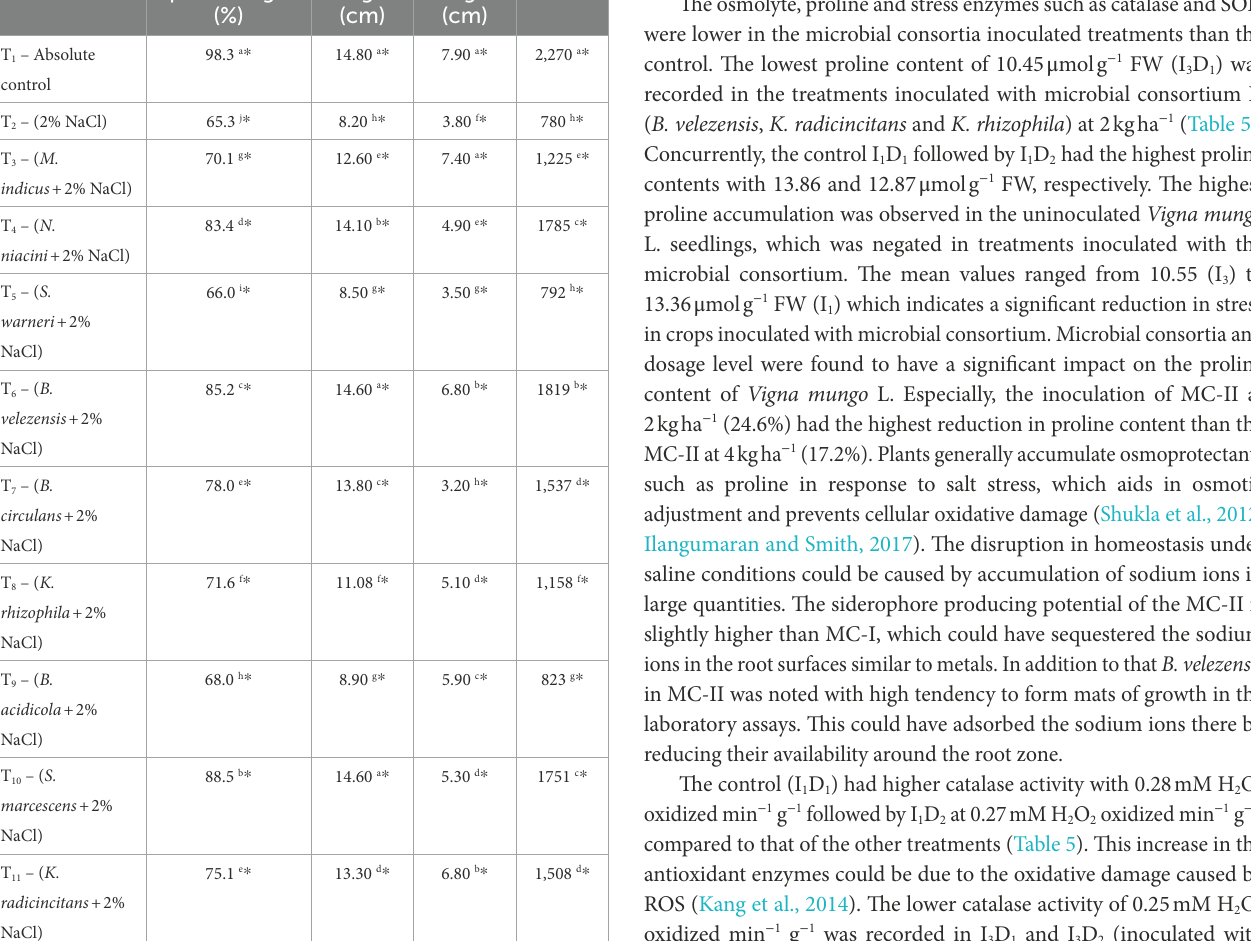
TABLE 4 In vivo evaluation of isolates for salinity stress alleviation in Vigna mungo L. under 2% NaCl. Treatments